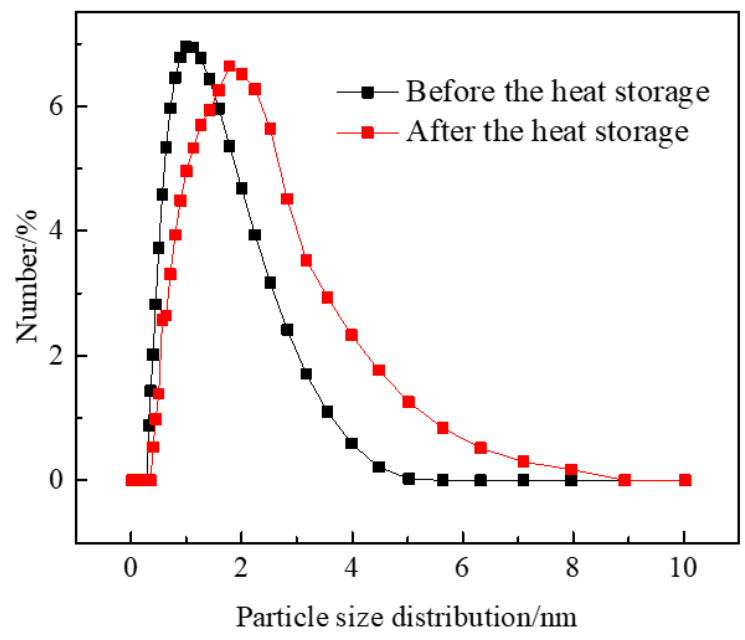
Figure 10. The effect of heat storage on pendimethalin particle size.